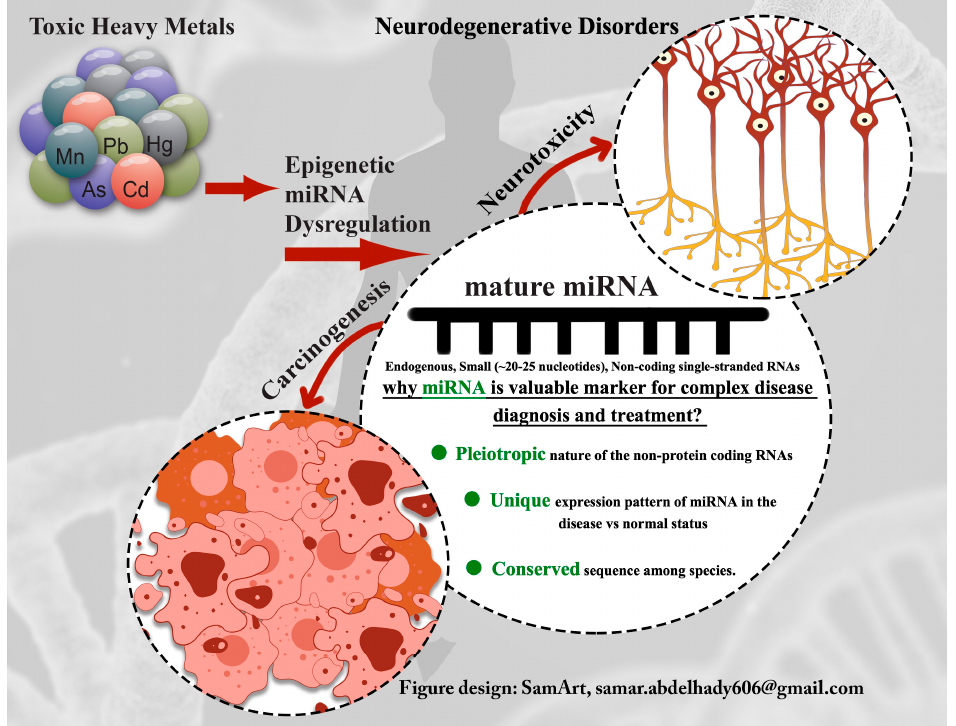
Figure 1. Toxic-metal-induced alteration in miRNA expression profile as a proposed mechanism for disease